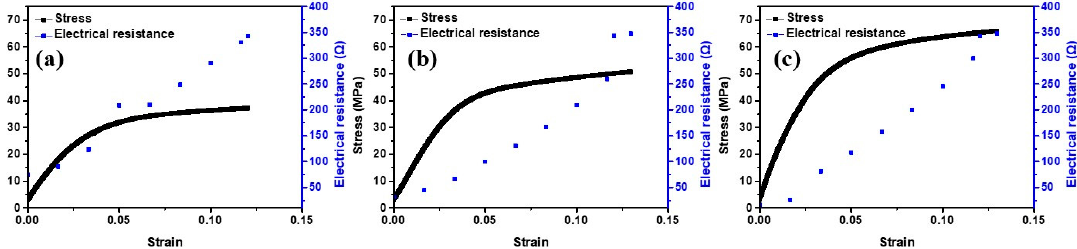
Figure 5. Engineering stress–strain curves and in ‐ situ electrical resistances of Pt/PET prepared with ( a ) 30 min ( b ) 45 min ( c ) 60 min of the Pt deposition time.